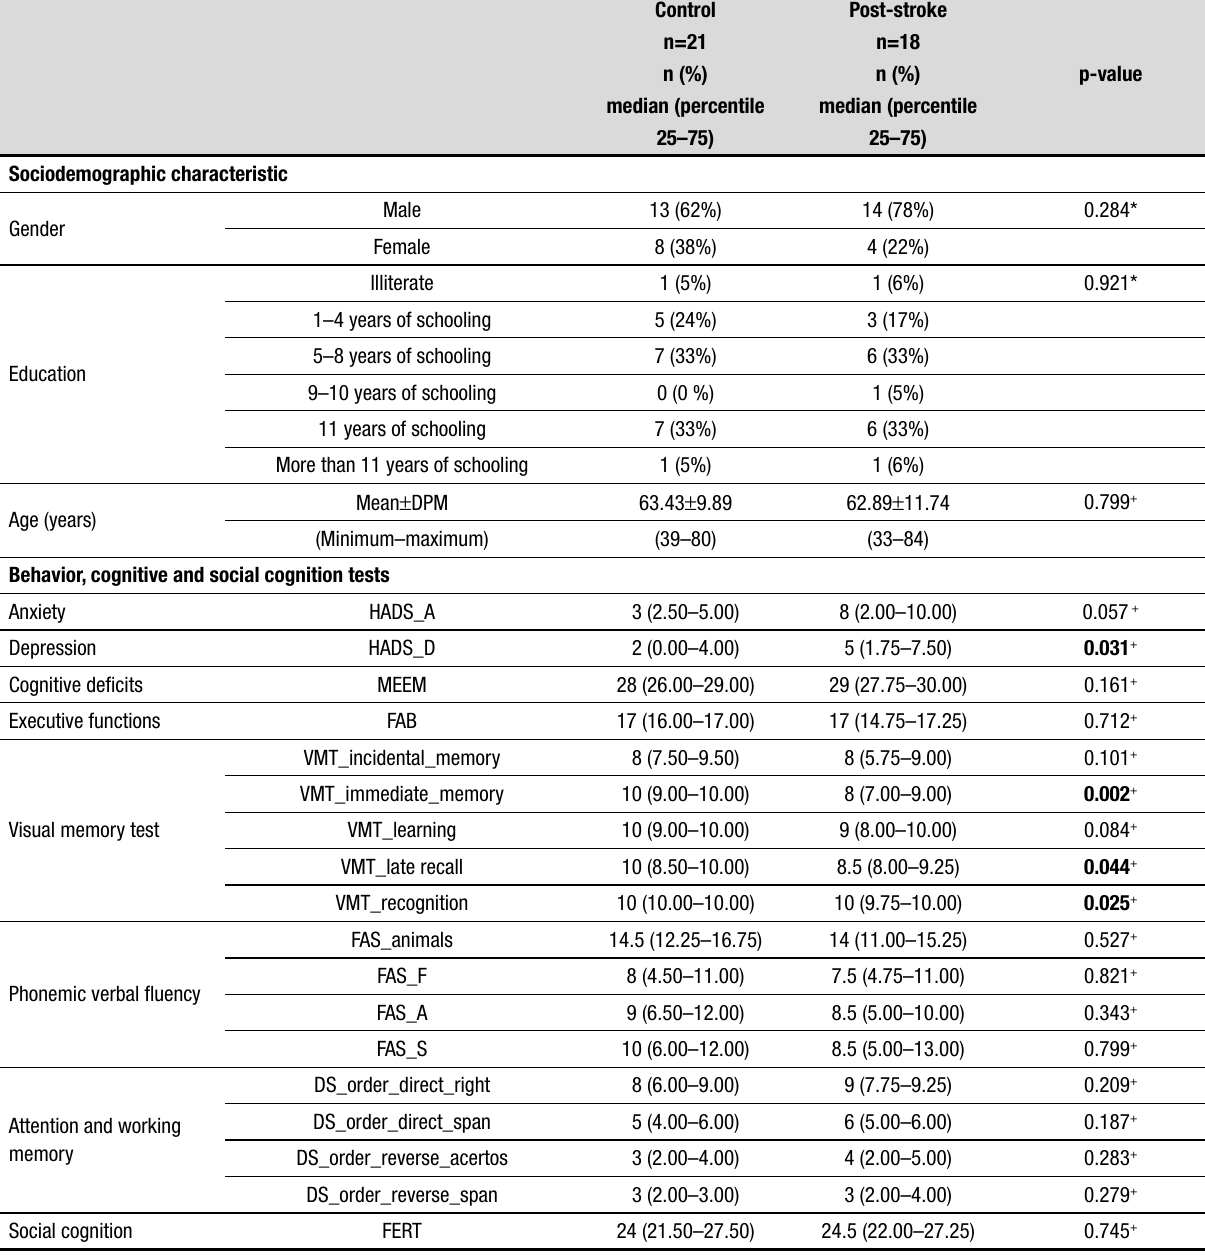
Table 1. Sociodemographic characteristic and neuropsychological performance of stroke follow-up and control groups.